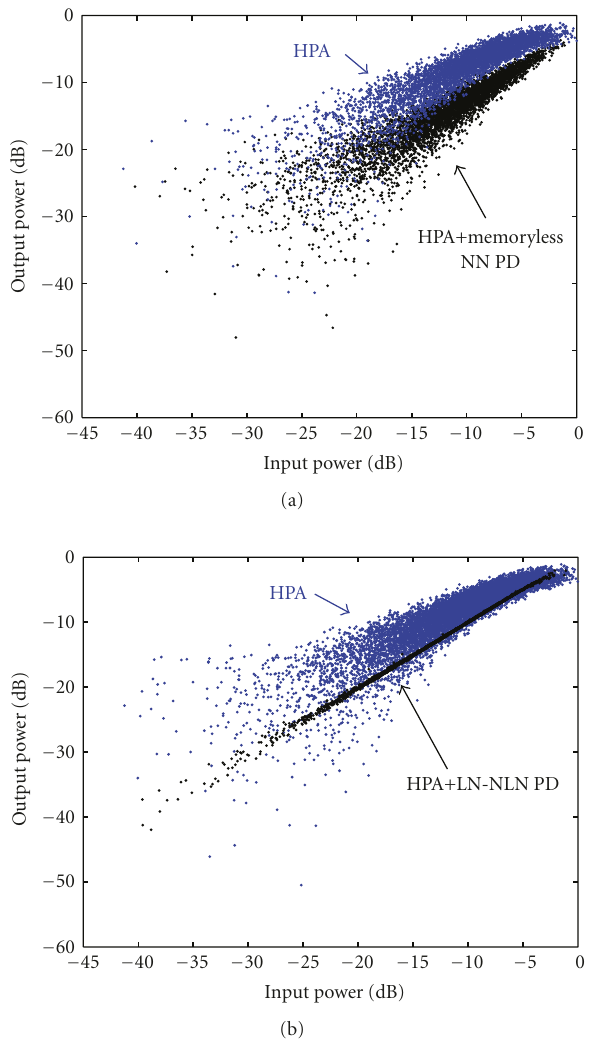
Figure 26: AM/AM curves for: (a) memoryless NN PD, (b) LN- NLN PD.